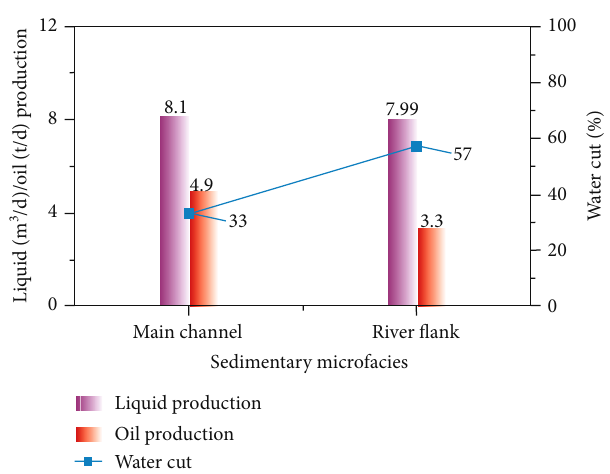
Figure 14: Statistics of initial production of di ff erent sedimentary microfacies in the Yan 9 32 layer.